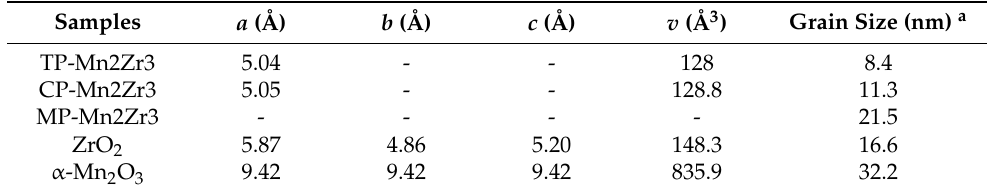
Table 1. Data obtained from XRD analyses of two-step precipitation (TP), conventional coprecipita- tion (CP), ball milling process (MP)-Mn2Zr3, ZrO 2 , and α -Mn 2 O 3 samples.